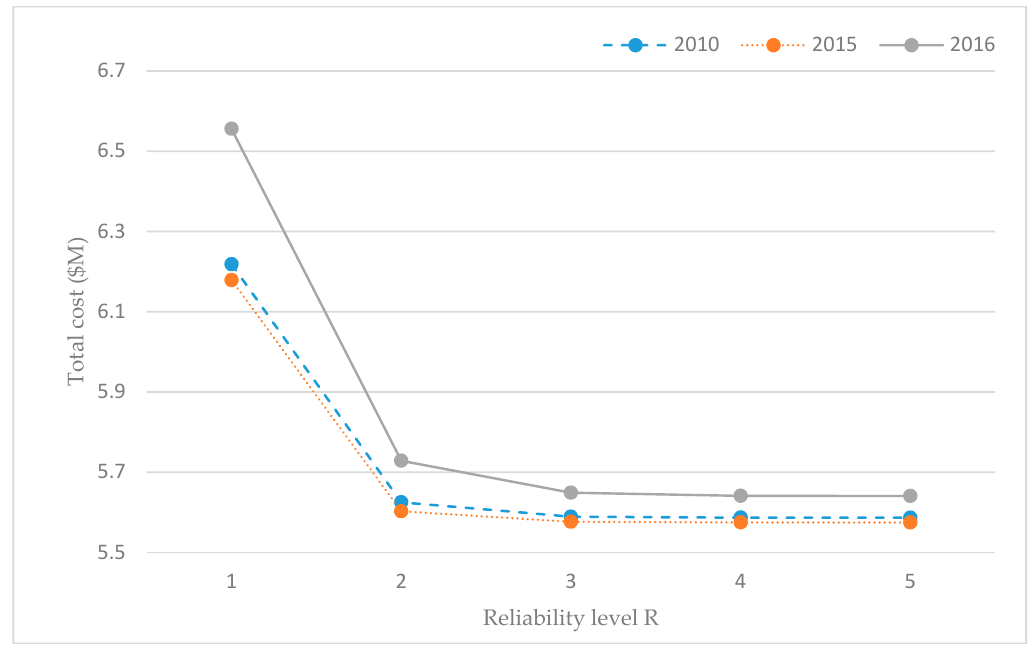
15 of 19 Table 3. Solutions statistics for the four cases. Case